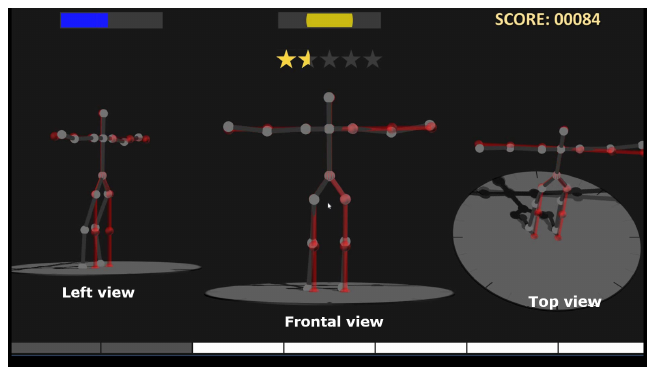
Figure 1. Arm Extension of the KINOPTIM exergame protocol. In the figure is depicted the frontal view, the lateral view, and the top view of the body posture. In red the posture of the participant and in gray the required posture.